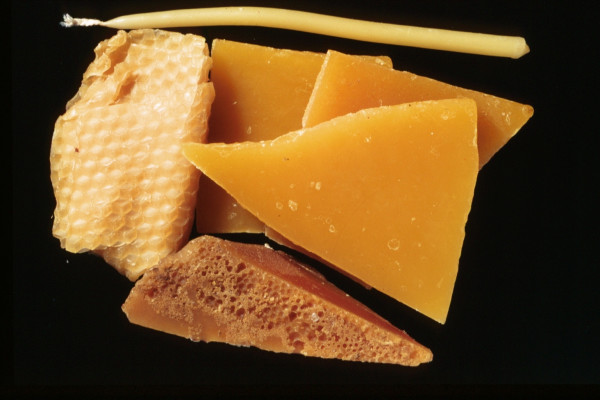
Wax (Apis mellifica).